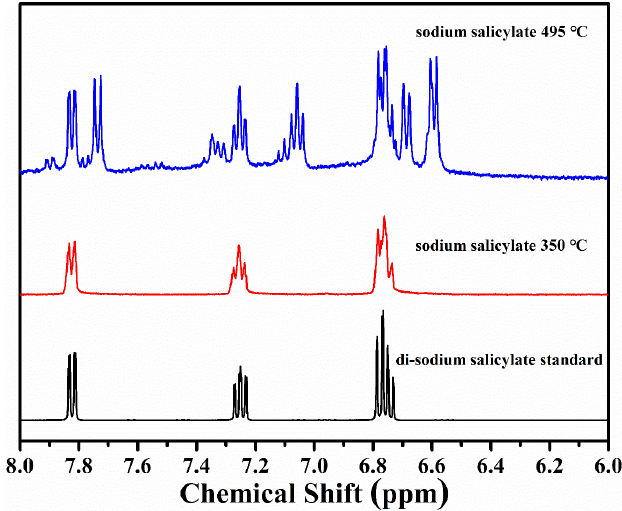
Figure 12. 1 H NMR spectra of thermally treated sodium salicylate.